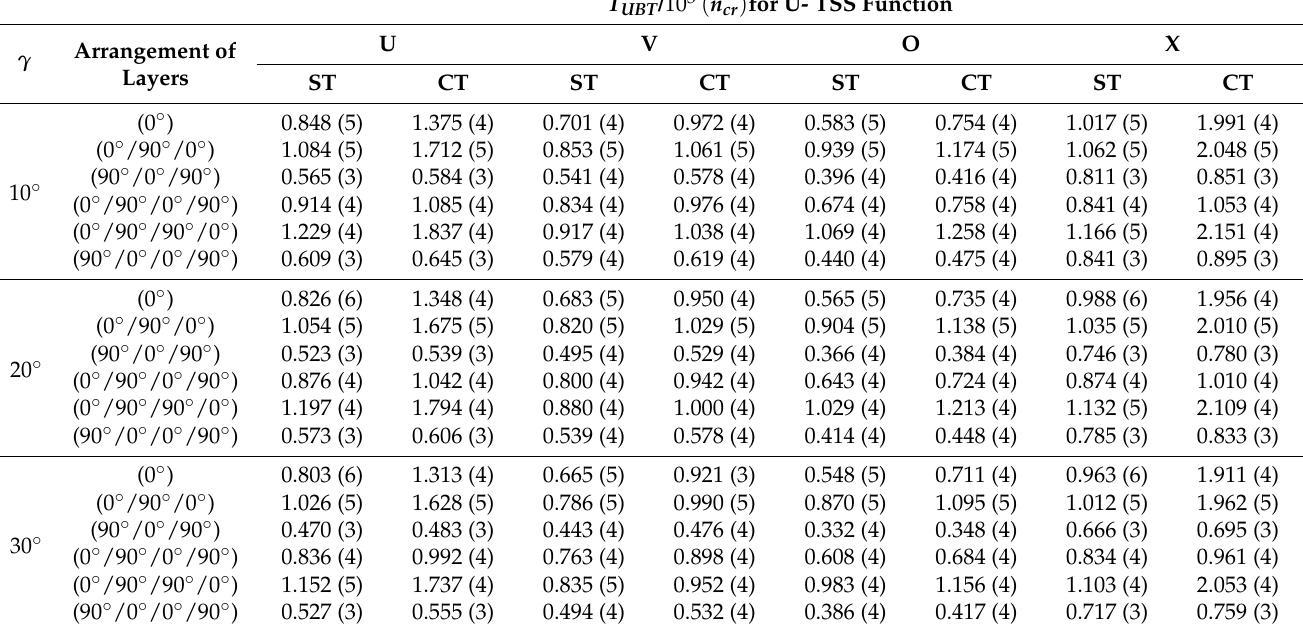
Table 4. Variations of UBT for single-layer and laminated cones with CNT-shaped layers for the U- TSS function (within CT versus γ